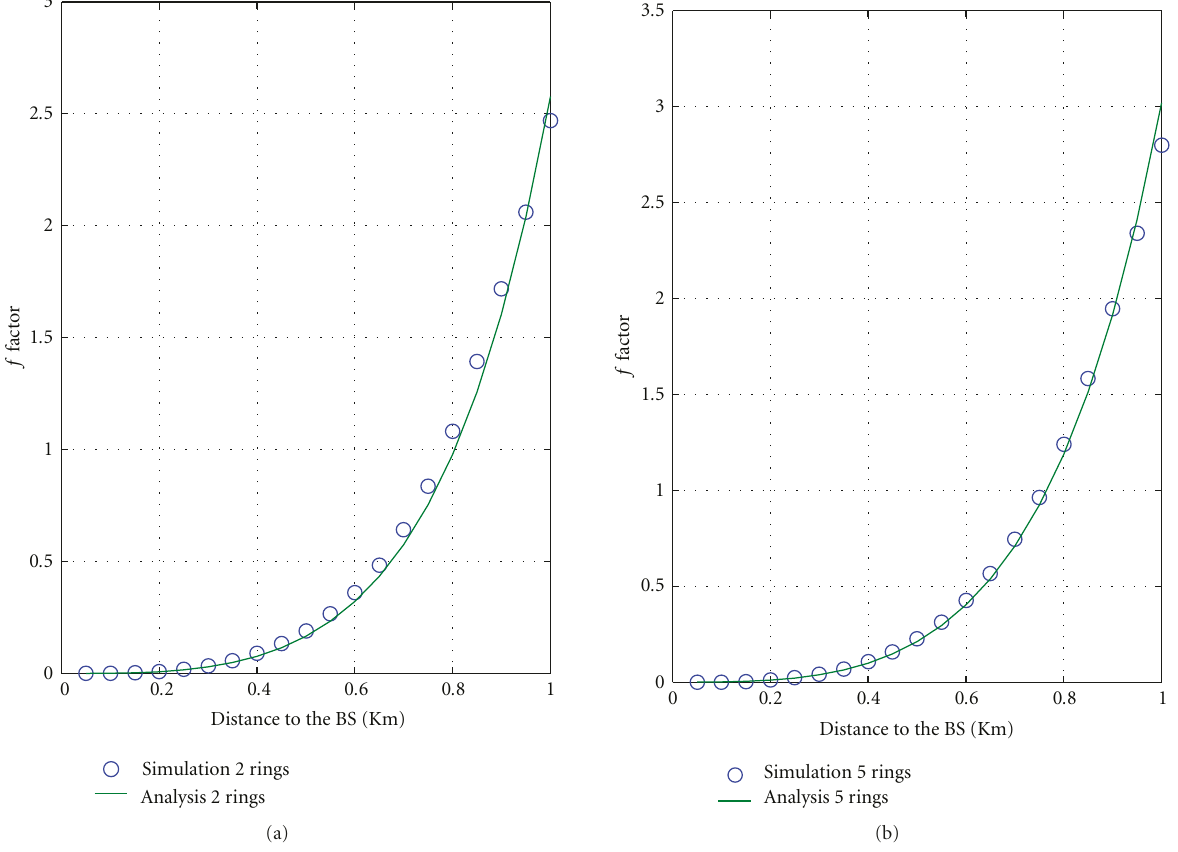
Figure 5: OCIF versus distance to the BS; comparison of the fluid model with simulations on a two ring (a) and a five ring (b) hexagonal network ( η =